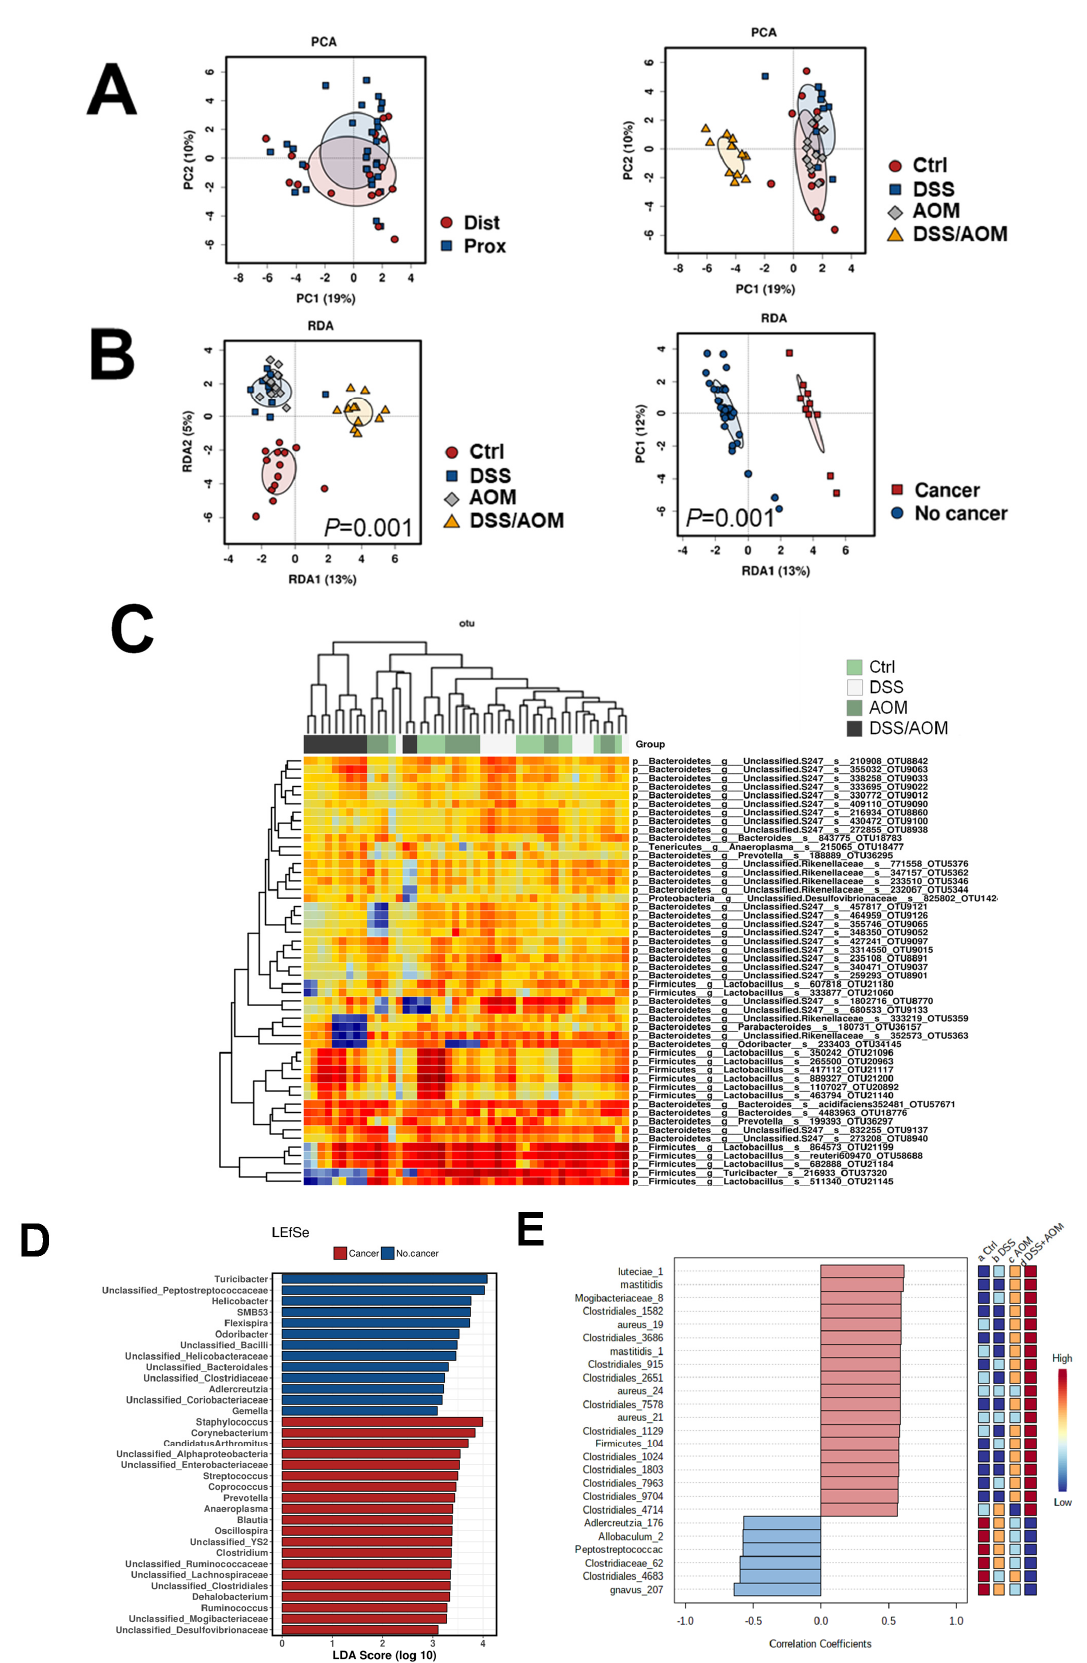
Figure 4. Metagenomic profiling of fecal microbes in mouse DSS/AOM-induced colon cancer. 16S rDNA metagenomic sequencing was performed to generate OTU abundances in proximal (Prox) and distal (Dist) colon fecal samples from control, DSS-, AOM- and DSS/AOM-treated mice. ( A ) Principal component analysis showing dissimilarity between site and treatment. ( B ) Redundancy analysis (RDA) showing significance of treatment cancer as a factor contributing to vari- ation in microbial composition of fecal microbes. ( C ) Hierarchical clustering and heatmap of core taxa (top 300 OTUs). ( D ) Genus-level LEfSe (Linear discriminant analysis Effect Size) analysis showing taxa associated with cancer (DSS/AOM) and no cancer (Control, DSS and AOM). ( E ) Pearson correlation analysis showing the top 25 taxa correlated to treatment. Ctrl; control, DSS, dextran sodium sulfate; AOM, azoxymethane, DSS/AOM; dextran sodium sulfate + azoxymethane, LDA; linear discriminant analysis.